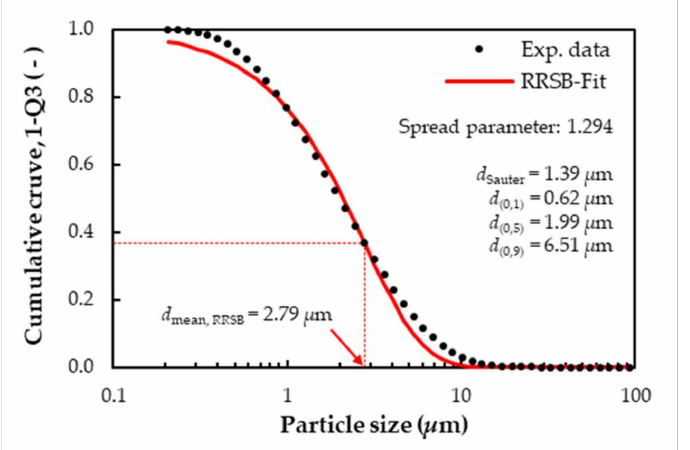
Figure 6. Experimental data of CeO 2 particle size distribution; black dots are measured data and the red line is the fitted RRSB distribution